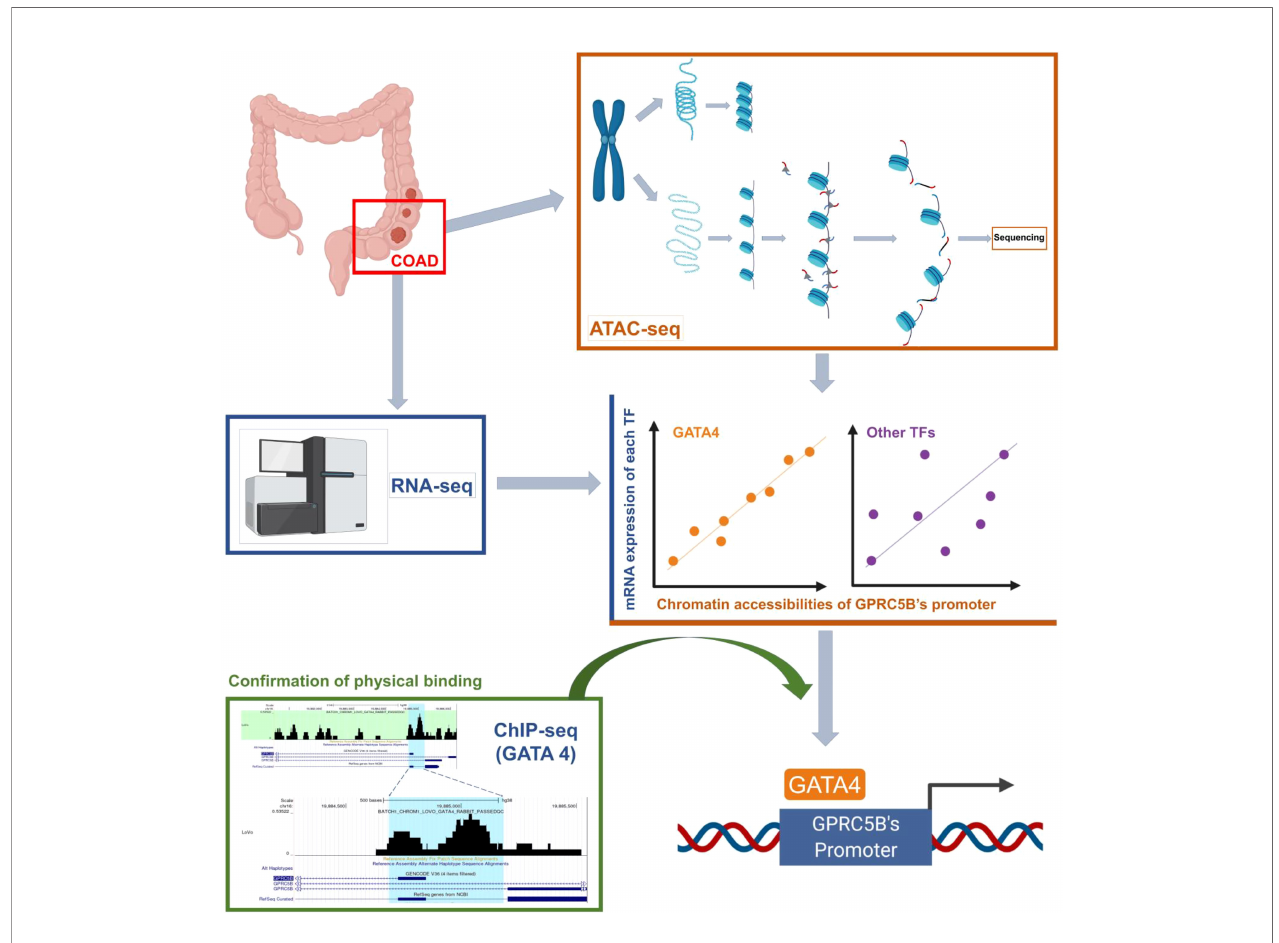
FIGURE 7 | Visualization of the detailed steps of our novel